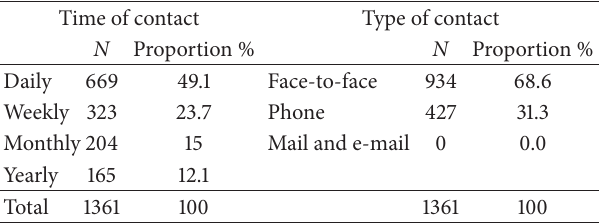
Table 6: Multiple linear regressions for characteristics of